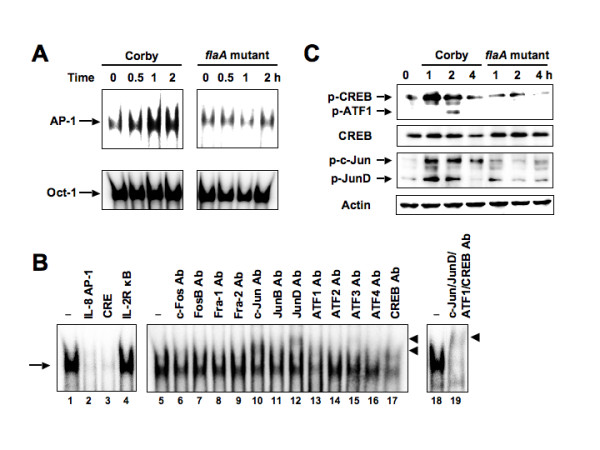
L. pneumophila activates AP-1 signal through flagellin. (A) Time course of AP-1 activation in Jurkat cells infected with L. pneumophila, evaluated by EMSA. Nuclear extracts from Jurkat cells, infected with Corby or flaA mutant (MOI, 100:1), for the indicated time periods, were mixed with IL-8 AP-1 32P-labeled probe. (B) Sequence specificity of AP-1 binding activity and characterization of AP-1/CREB/ATF proteins that bound to the AP-1 binding site of the IL-8 gene. Competition assays were performed with nuclear extracts from Jurkat cells infected with Corby for 2 h. Where indicated, 100-fold excess amounts of each specific competitor oligonucleotide were added to the reaction mixture with labeled probe AP-1 (lanes 2 to 4). A supershift assay of AP-1 DNA binding complexes in the same nuclear extracts also was performed. Where indicated, appropriate antibodies (Ab) were added to the reaction mixture before the addition of the 32P-labeled probe (lanes 6 to 17 and 19). Arrows indicate specific complexes, while arrowheads indicate the DNA binding complexes supershifted by antibodies. (C) Jurkat cells were infected with Corby or flaA mutant for the indicated time periods. Cell lysates were prepared and subjected to immunoblotting with the indicated antibodies. Data are representative examples of three independent experiments with similar results.